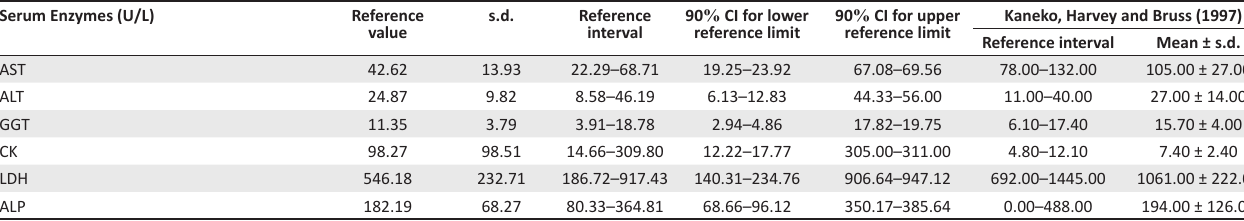
TABLE 2: Reference intervals for serum enzyme activities in buffalo heifers. Serum Enzymes